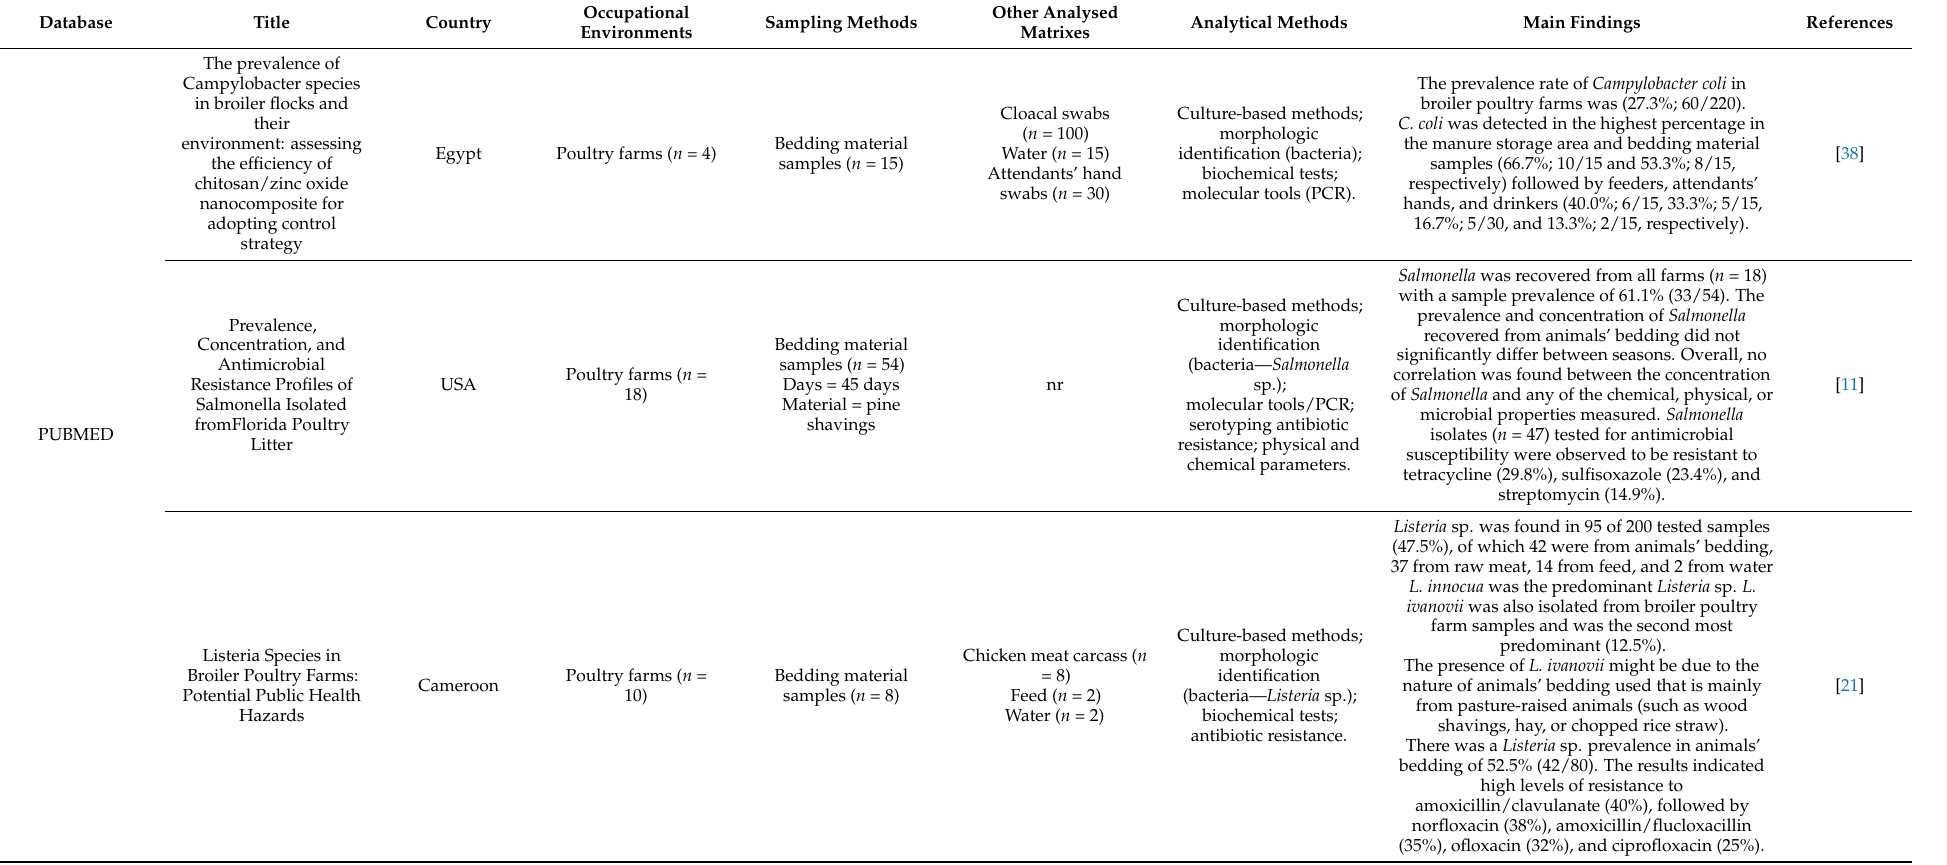
Table 2. Data selected from the chosen